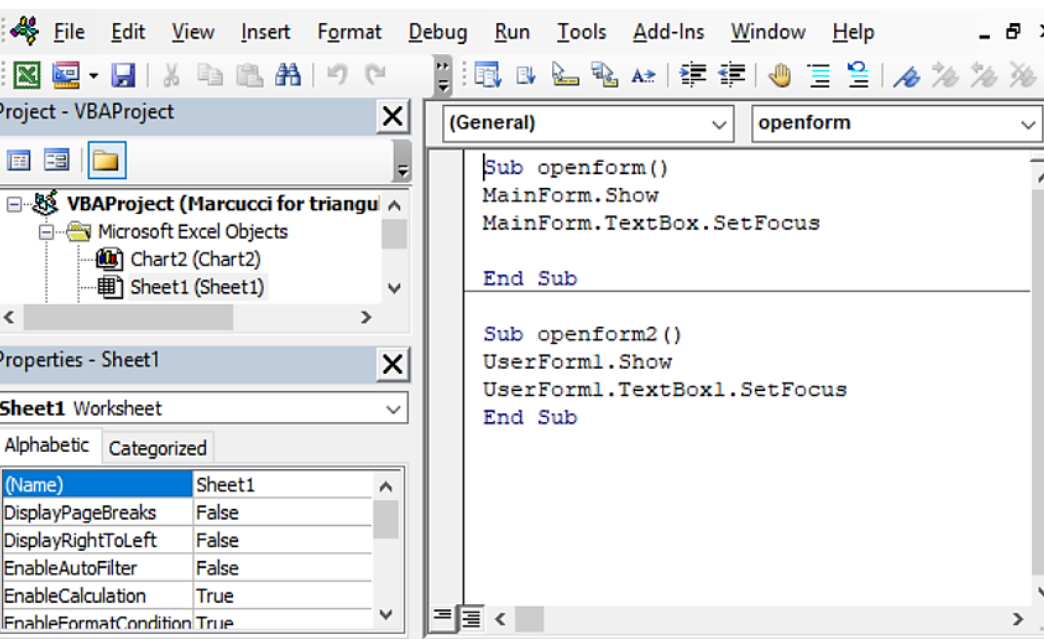
Figure 8. Visual Basic Coding for the Input Box in the Excel Sheet.